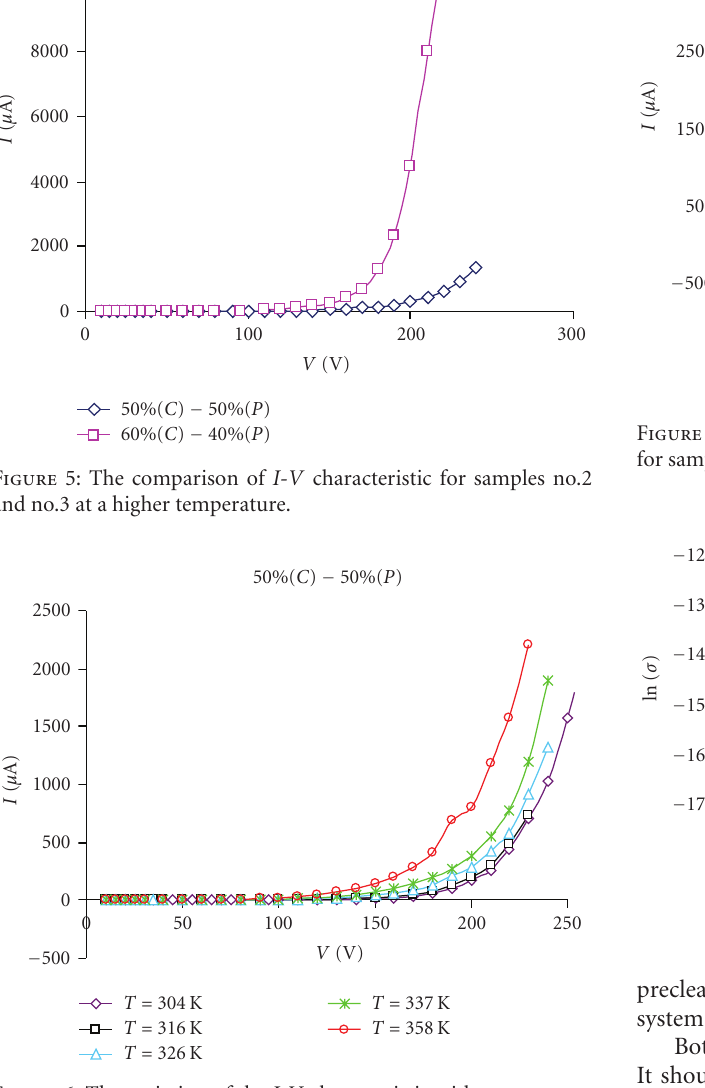
Figure 6: The variation of the I-V characteristic with temperature for sample no.2.